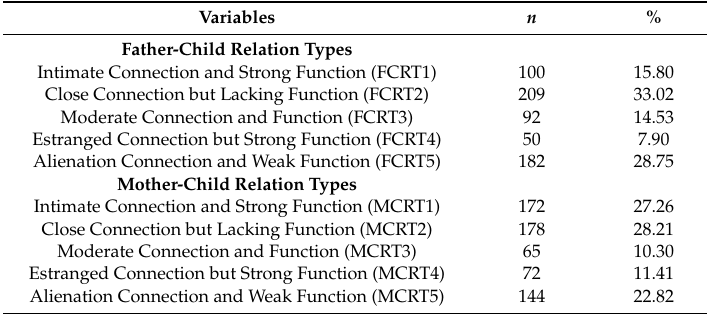
Table 7. Characteristics of parent-child relation